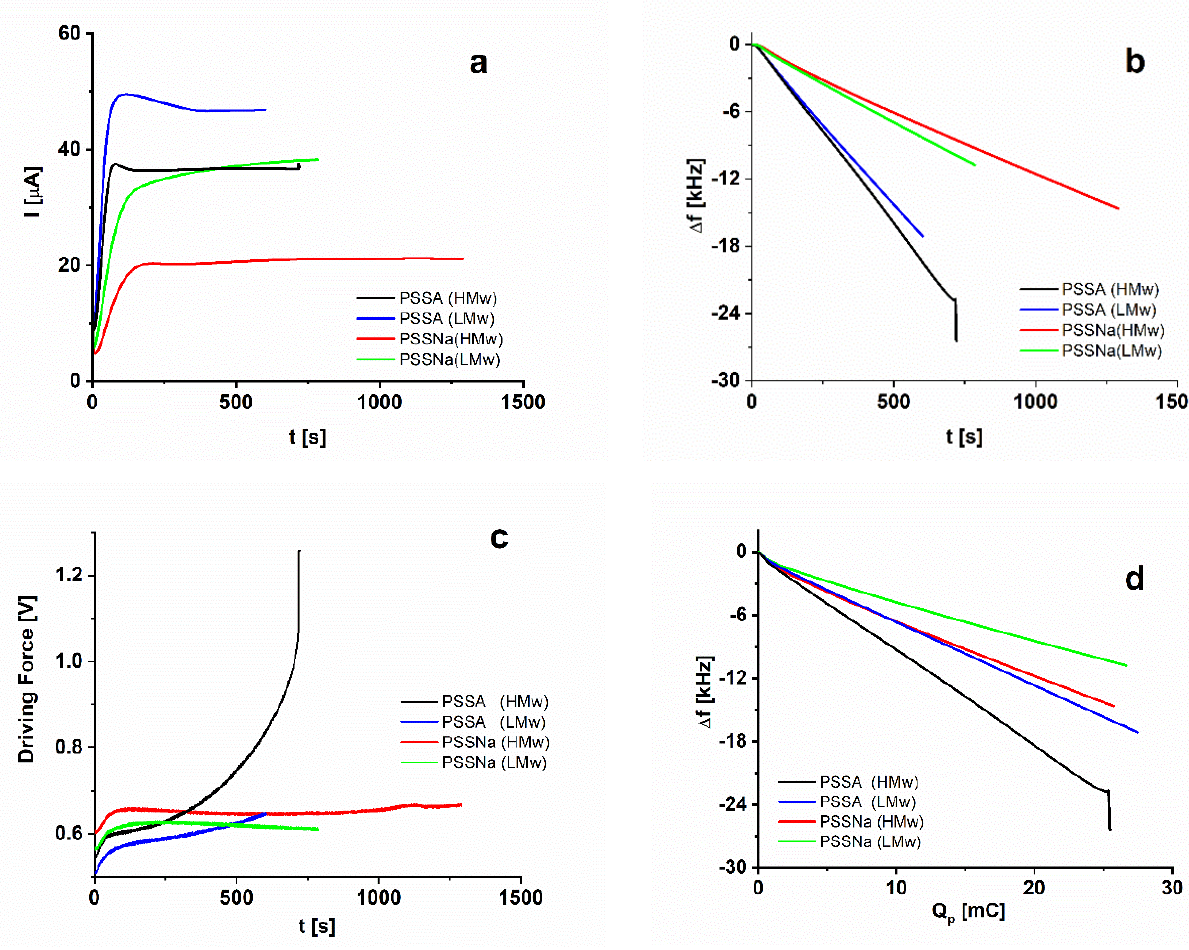
Figure 2. Current ( a ), frequency shift ( b , d ), and driving force ( c ) measurements in the course of potentiostatic polymerization in the presence of PSSA (HMw) (black), PSSA (LMw) (blue), PSSNa (HMw) (red) and PSSNa (LMw) (green).